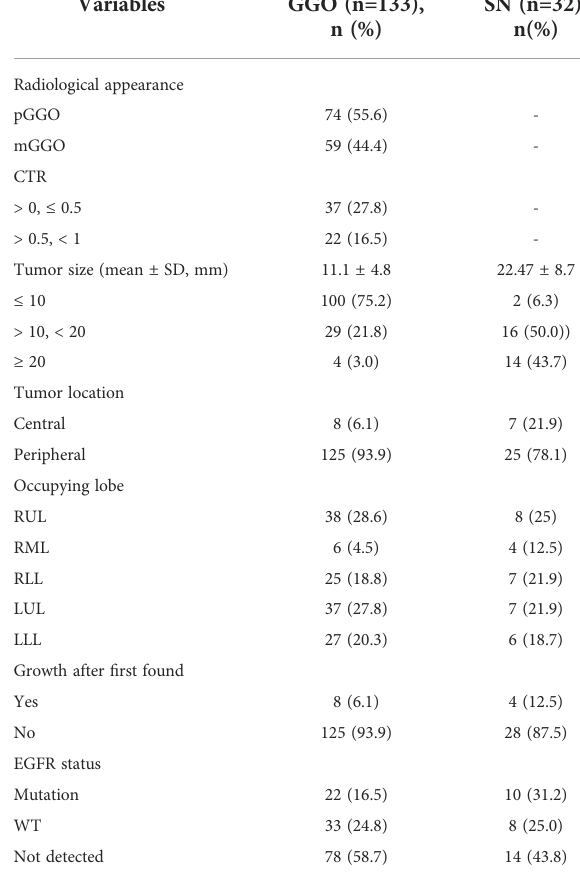
TABLE 2 Clinical characteristics of